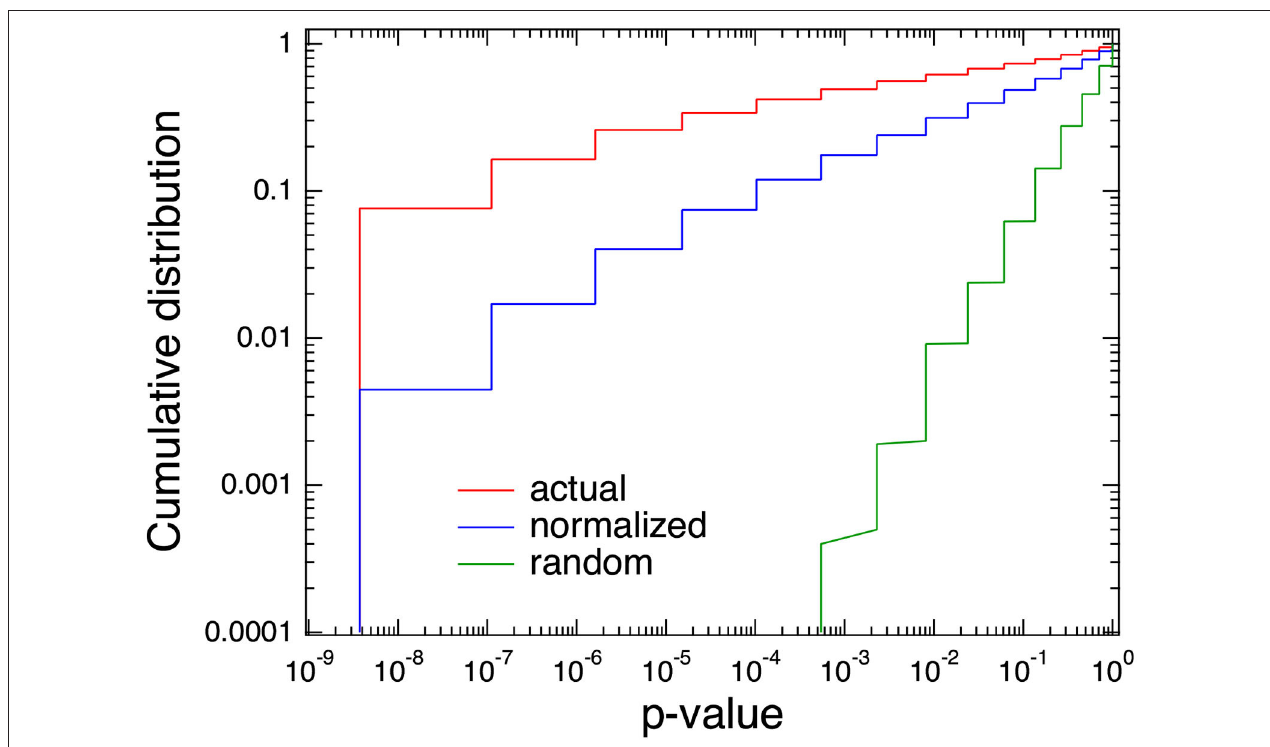
FIGURE 9 | Comparison cumulative distributions of p -values among actual, random, and normalized by order book